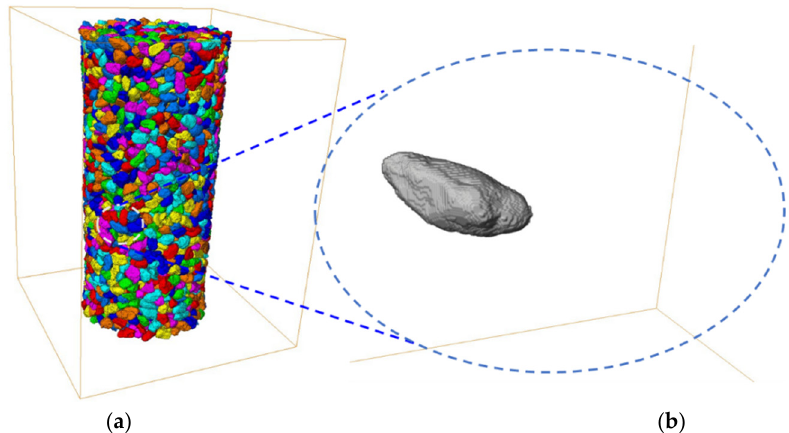
Figure 1. Image obtained from micro-tomography ( μ CT) reconstruction: ( a ) three-dimensional (3D) labeled image; ( b ) an individual particle.